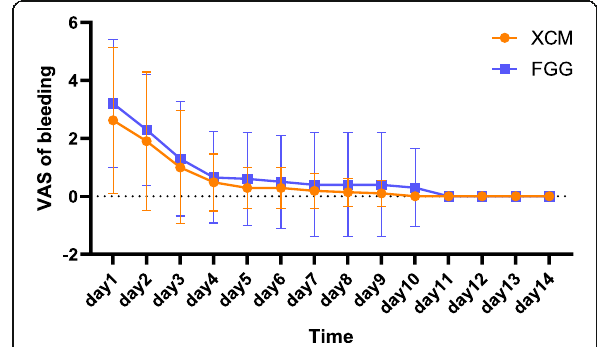
Fig. 4 Patients reported bleeding perception during the early healing stages